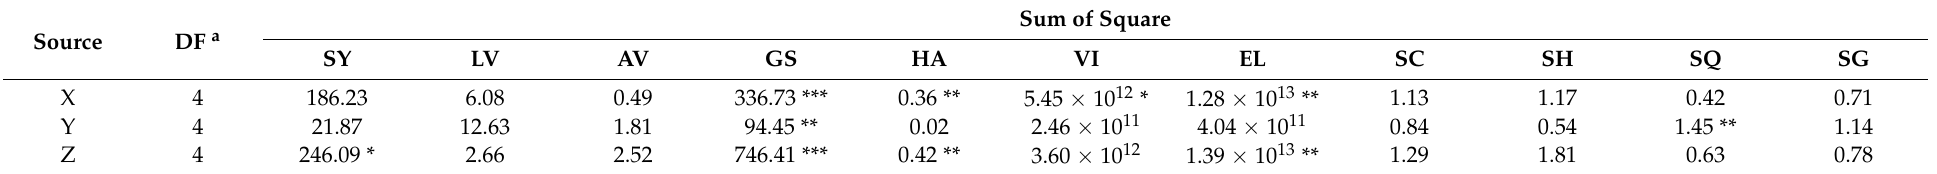
Table 5. Analysis of variance for the overall effect of process variables on the various